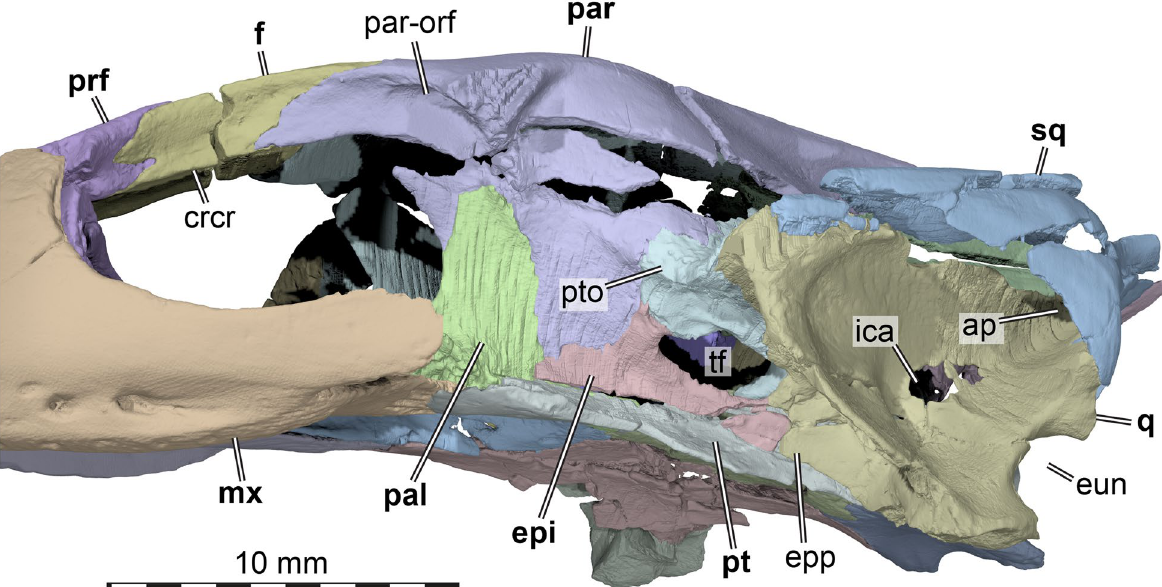
Fig. 7 Three dimensional renderings of the exterior trigeminal region of the cranium of Plastomenus thomasii (AMNH FR 6015). Partial cranium in left anterolateral and slight ventral view, with jugal and quadratojugal removed. Note that bones are labelled in bold. ap antrum postoticum, crcr crista cranii, epi epipterygoid, epp epipterygoid process of quadrate, eun Eustachian notch, f frontals (fused), ica incisura columellae auris, mx maxilla, pal palatine, par-orf orbital fossa of the parietal, par parietal, prf prefrontal, pt pterygoid, pto processus trochlearius oticum, q quadrate, sq squamosal, tf trigeminal